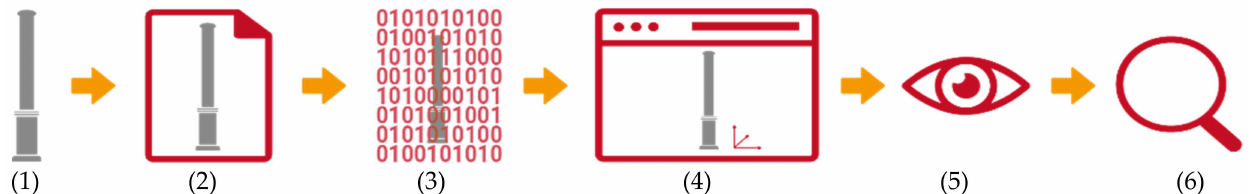
Figure 6. The digital transformation process: A historical column (1) is documented with sources (2) on the basis of which a digital model is created (3), which is mapped by a visualization (4), which is perceived by the researcher (5) to investigate a specific research question